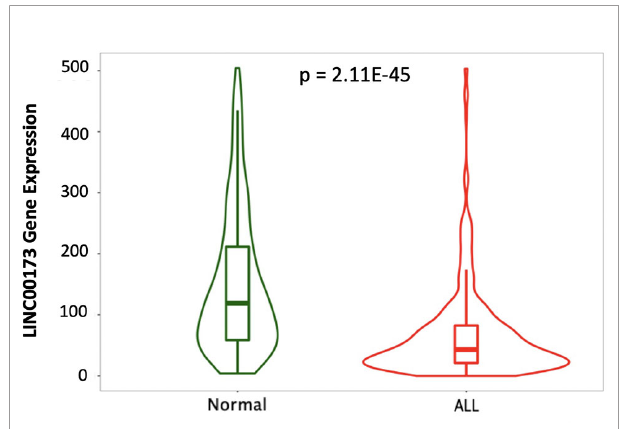
FIGURE 1 | LINC00173 is underexpressed in B-cell precursor acute lymphoblastic leukemia (BCP-ALL). LINC00173 expression differs among normal peripheral blood (GTEX) and BM of BCP-ALL in the TARGET cohort (data obtained from TNMplot and modi fi ed).